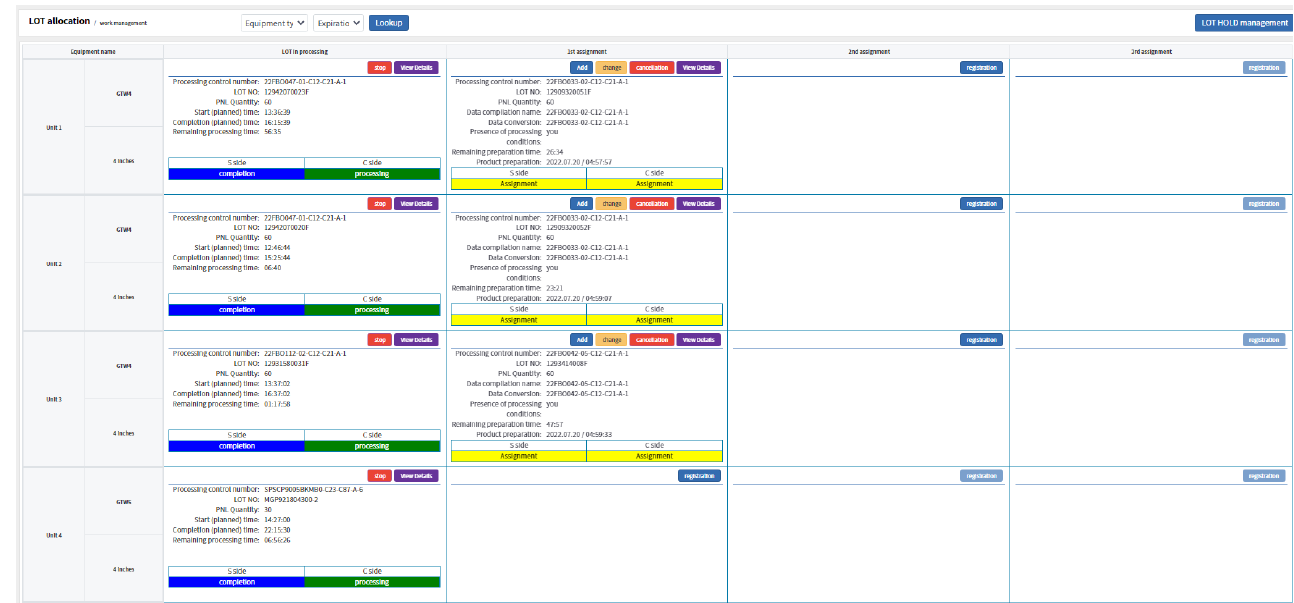
Figure 24. Task assignment status and link to work order by